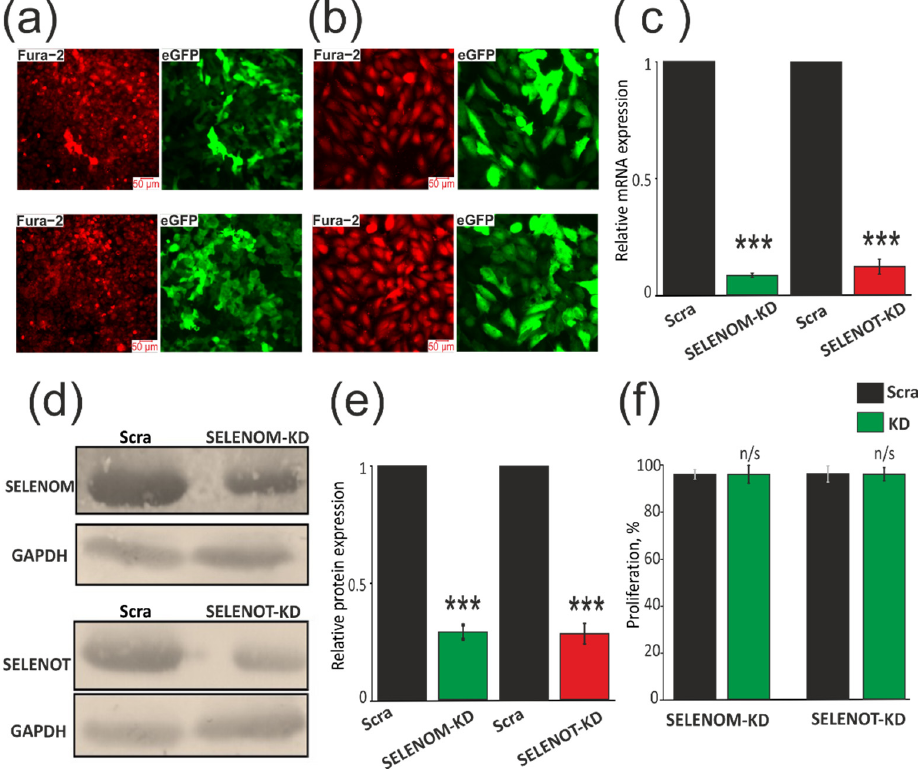
Figure 1. Evaluation of SELENOM-KD and SELENOT-KD efficiency by fluorescent microscopy ( a , b ), real-time PCR ( c ), and Western blotting ( d , e ). KD effect on cell proliferation. ( a , b ) Images of A-172 cell culture in Fura-2 fluorescence (Fura-2) at an excitation of 380 nm and eGFP fluorescence indicating efficiency of expression of the construct transduced into cells. ( c ) Real-time PCR analysis of mRNA expression of genes encoding SELENOM and SELENOT in A-172 cells transduced with constructs SELENOM-KD (or SELENOT-KD) and scrambled RNA (Scra). ( d ) Western blot analysis of SELENOM and SELENOT content in samples. ( d ) Quantification of the content of SELENOM and SELENOT in A-172 cells transduced with constructs SELENOM-KD (or SELENOT-KD) and scrambled RNA (Scra). Comparison of KD groups vs. Scra: *** p < 0.001. ( f ) Proliferation assay performed by MTT analysis. The optical density at 590 nm was measured, and the values of the respective untreated cells were defined as 100%. Standard deviations were determined by analysis of data from at least three independent experiments and were indicated by error bars. Comparison of KD groups vs. Scra: n/s—data not significant ( p > 0.05).